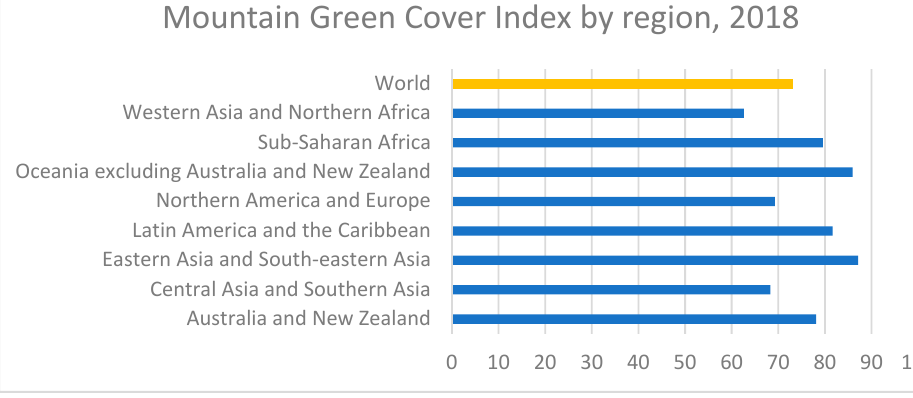
Figure 3. Mountain Green Cover Index by regions as defined by the System of Integrated Environ-